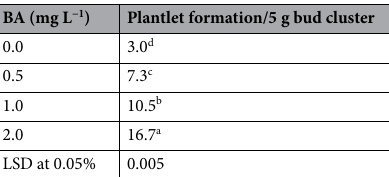
Table 1. Effect of different treatments of BA on the formation of plantlets from small bud clusters under light (16 h photoperiod).